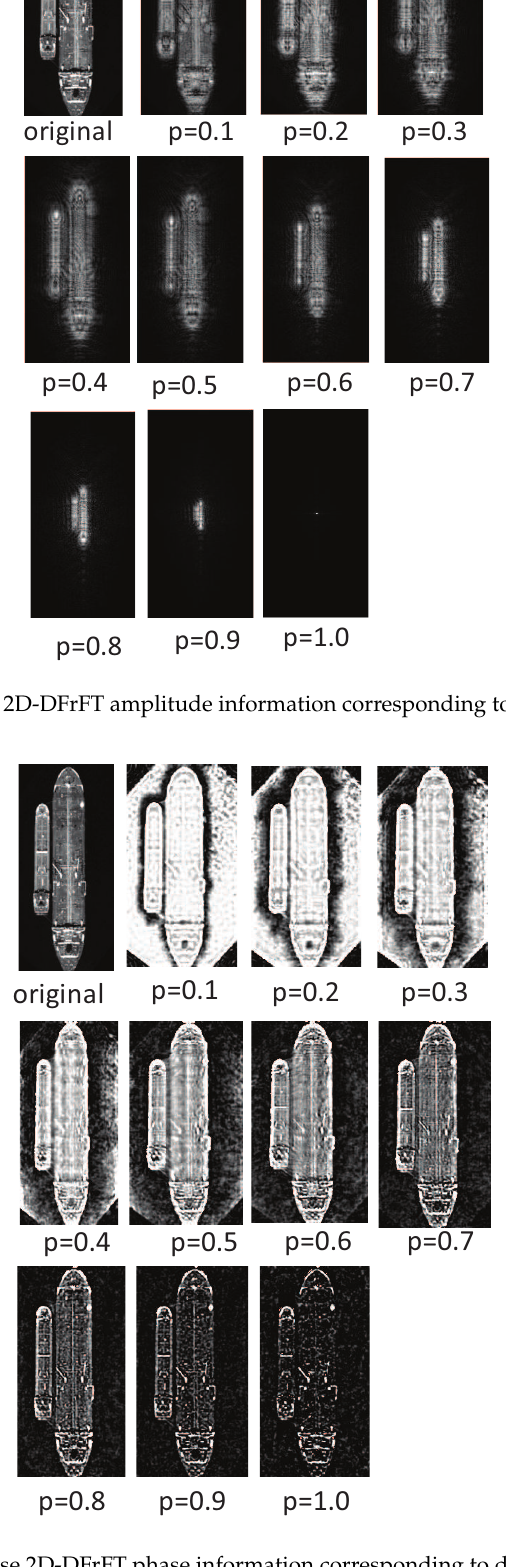
Figure 3. The inverse 2D-DFrFT phase information corresponding to different